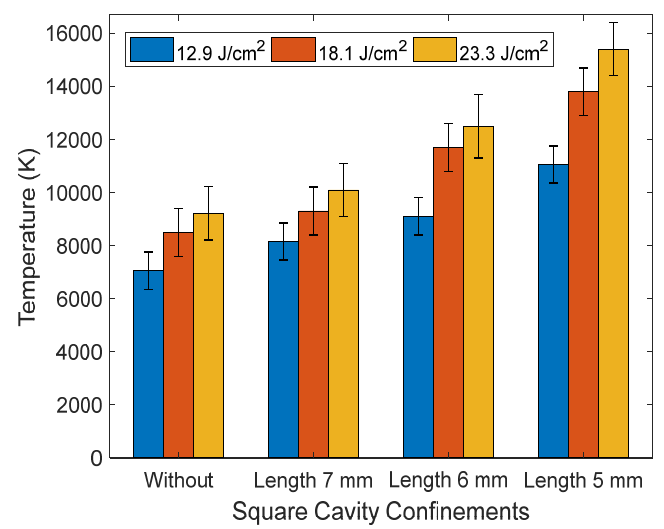
Figure 14. A graph of electron temperature versus the square cavities with different sizes and without cavity confinement, at laser fluences 12.9, 18.1 and 23.3 J cm − 2 .